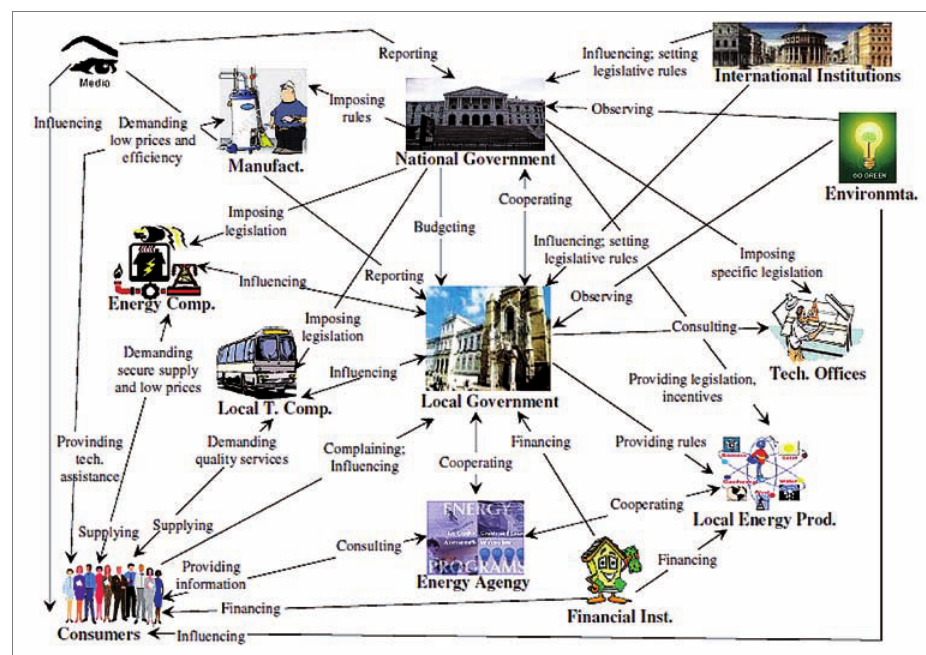
Fig. 1. The rich picture of urban energy